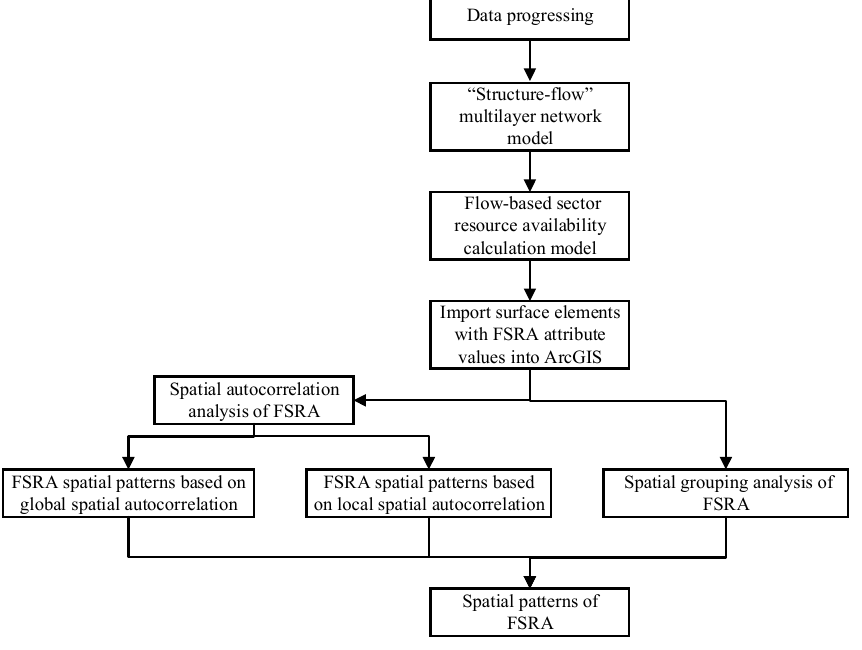
Figure 1. The structure of the proposed framework